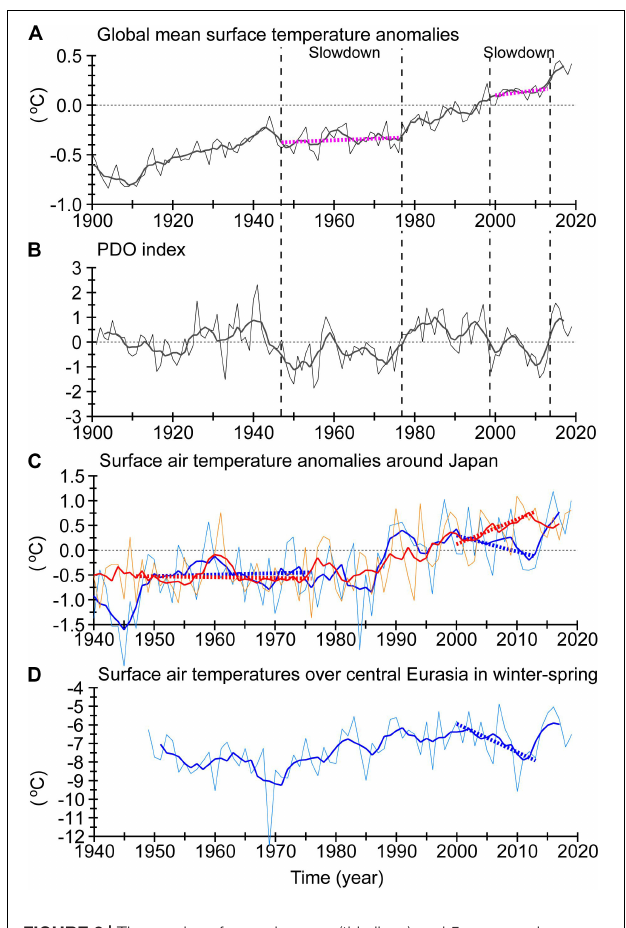
FIGURE 2 | Time-series of annual means (thin lines) and 5-year running means (thick lines) of four climate-related indicators. Thick dashed lines denote linear trends. (A) Global mean surface temperature anomalies. (B) Time series of PDO index. (C) Land surface air temperature anomalies over Japan. In (C) , orange and red (light and dark blue) lines indicate air temperatures for summer–autumn (winter–spring). (D) Land surface air temperatures in winter–spring over central Eurasia (the rectangular area from 50 to 120 ◦ E and 45 to 62 ◦ N; see Figure 3A ). Data for (A–C) were downloaded from the Japan Meteorological Agency, and data for (D) are based on NCEP/NCAR reanalysis data.